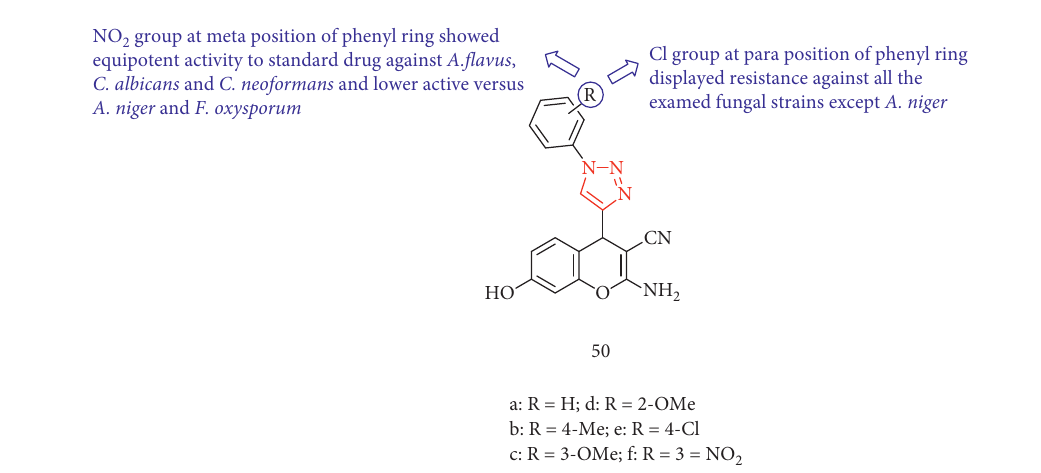
Figure 9: Chemical structure of novel 1H-1,2,3-triazole-tethered 4H chromene-D-glucose conjugates.